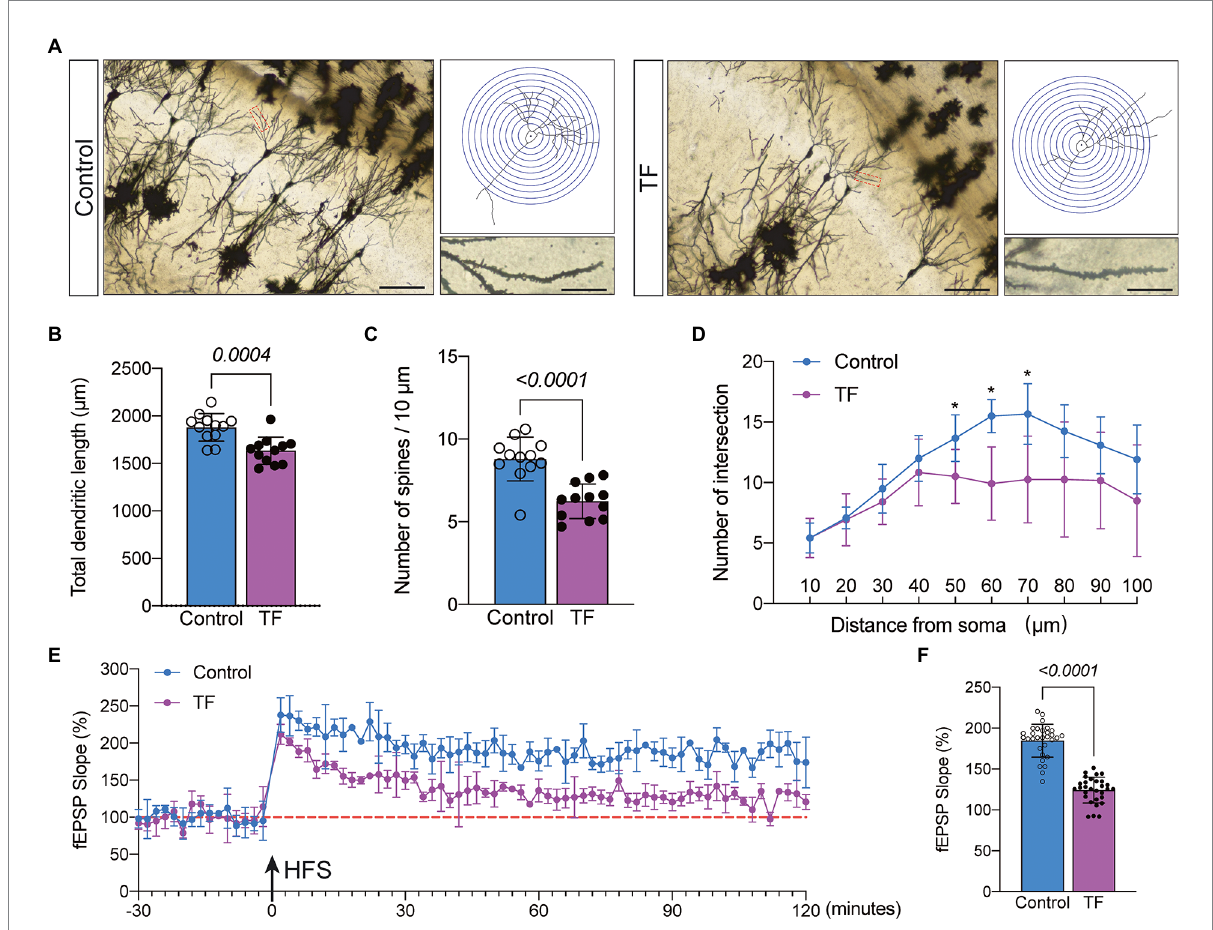
FIGURE 3 Synaptic plasticity in hippocampal CA1 region at day 10 after fracture surgery. (A) Golgi staining of the CA1 region of the mouse hippocampus (×200, n = 3), Sholl analysis and magnification of synapses (×1,000), scale bar = 100 or 20 μ m. (B–D) Quantitative analysis of total synaptic length, synaptic spine density and synaptic number. The Number of intersection was analyzed using unpaired t -test with Bonferroni corrected p -values. (E) Recording and analysis of local field potentials in the CA1 region of the hippocampus in response to stimulation of Schafer’s lateral branch fibers ( n = 3). (F) Average fEPSP Slop in the last 20 min. * p < 0.05, compared with the C group. Data are presented as mean ± SD. Data were expressed as mean ± SD and analyzed using two-tailed unpaired t -test. The p -values are shown in the